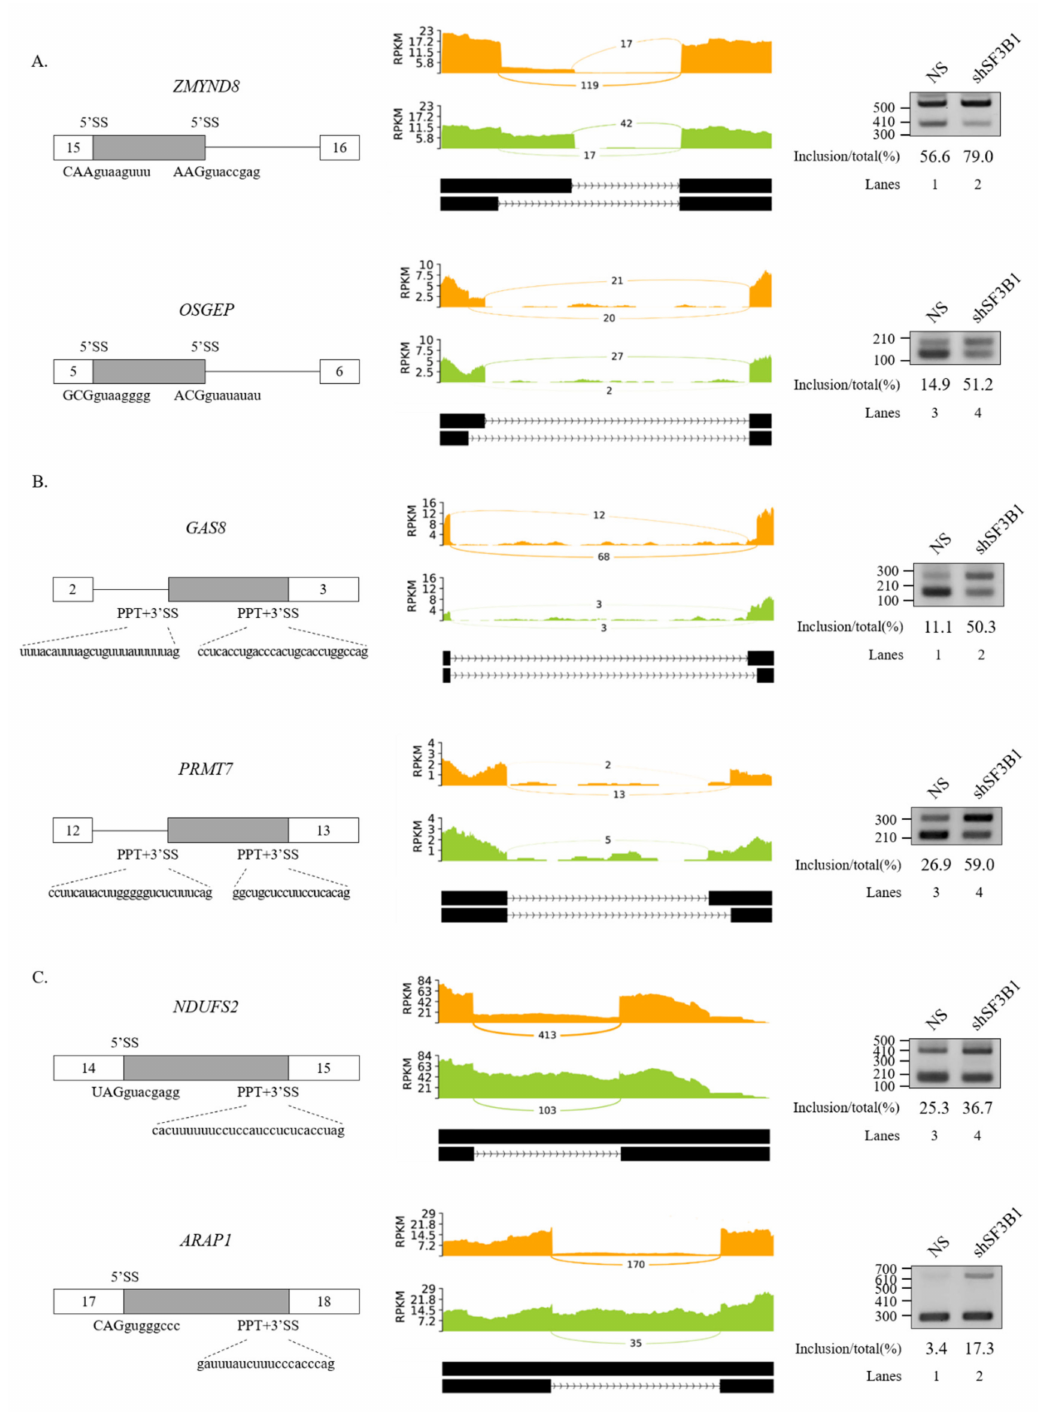
Figure 3. Validation of regulated A5SS, A3SS, and RI in SF3B1 KD cells. ( A – C ) (Left) Schematic representation of alternative splice sites in genes. Sequences of two alternative 5 (cid:48) SSs ( A ); two alternative 3 (cid:48) SSs and PPTs ( B ); and 5 (cid:48) SSs, 3 (cid:48) SSs, and PPTs of introns ( C ) are shown. (Middle) Sashimi plots of validated A5SS ( A ), A3SS ( B ), and RI ( C ) in RNA-seq. (Right) RT-PCR analysis of altered A5SS ( A ), A3SS ( B ), and RI ( C